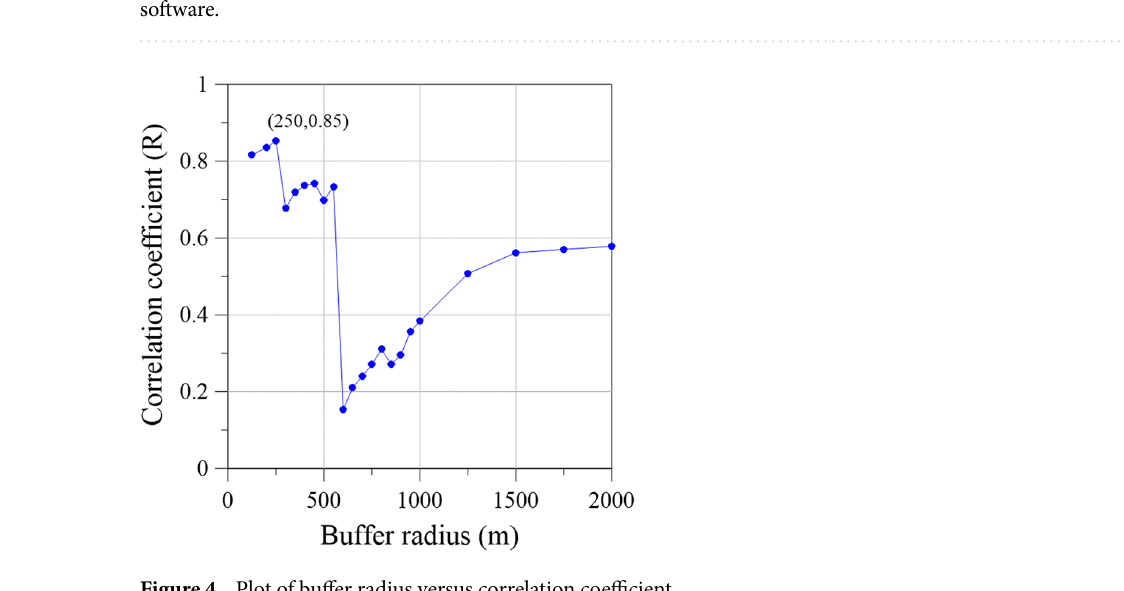
Figure 4. Plot of buffer radius versus correlation